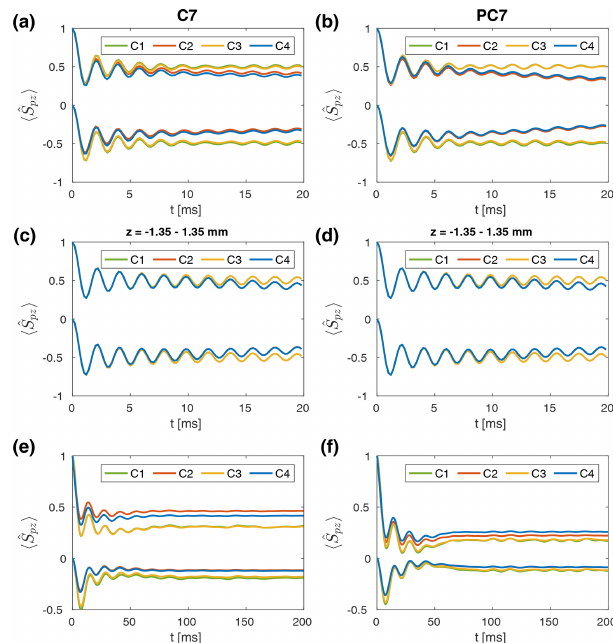
Figure 9. Simulated ˆ S 1 z → ˆ S 2 z polarization transfers in CC spin systems during C7 (a, c, e) and POST-C7 (b, d, f) recoupling for C1–C4 in a 3.2mm probe. A nominal rf field amplitude of 70kHz and a spinning frequency of 10kHz was assumed. Simulations shown in panels (a–d) were performed at a carbon resonance fre- quency of 150MHz. Resulting expectation values of ˆ S 1 z and ˆ S 2 z for a spin pair with isotropic chemical shifts that are symmetric around zero ( (cid:127) 1 = − (cid:127) 2 ) and a value of 4.5kHz for δ IS are shown for the 2 π full rotor (a, b) and for a spatially restricted sample (central third along rotor axis; (c, d) . Overall, rf field amplitude modulations (C2 and C4) lead to a slight deterioration in the recoupling performance for both sequences. The other two cases (C1 and C3) are nearly identical. (e, f) Simulation results for a CC spin pair with consid- at a lower magnetic erable CSA and a value of − 585Hz for δ IS 2 π field (carbon resonance frequency of 75MHz) for C7 (e) and POST- C7 (f) recoupling. Lower overall transfer efficiencies are observed for this spin system, and modulations of the rf field amplitude (C2 and C4) further deteriorate the recoupling performance (C1 and C3 are indistinguishable). This effect is stronger for